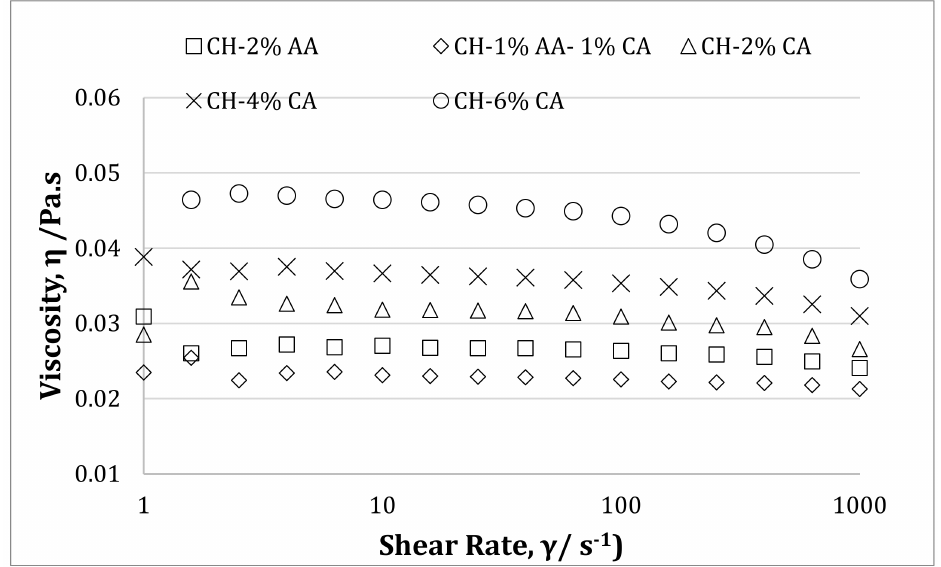
Figure 6. Shear flow curves of chitosan solution prepared with acetic acid (2% v / v ) and citric acid (2, 4, and 6% w / v